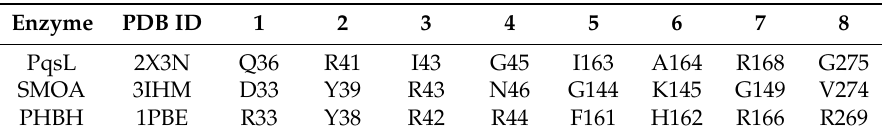
Table 3. Comparison of critical amino acid residues that are probably involved in nicotinamide binding in PHBH with respective residues of StyA and PqsL